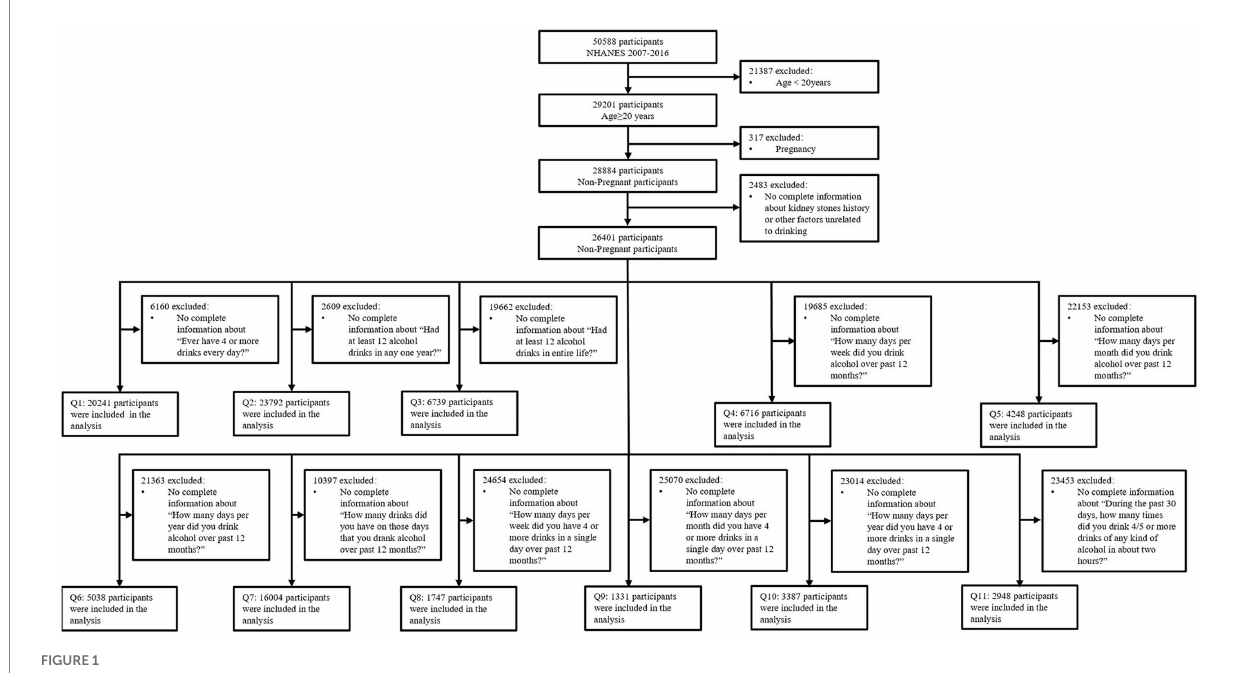
FIGURE 1 Flow chart of the study